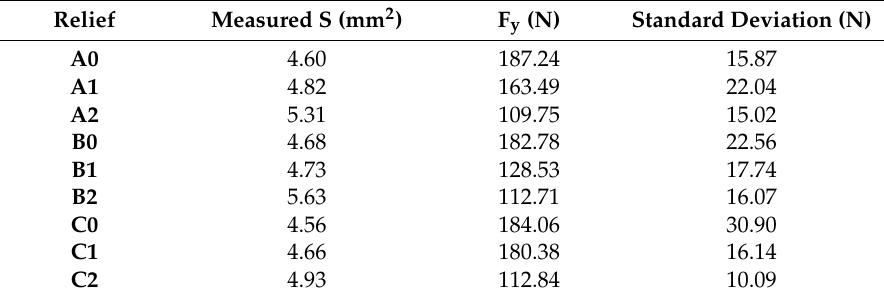
Table 3. Results of the area of specimens and tensile strength.